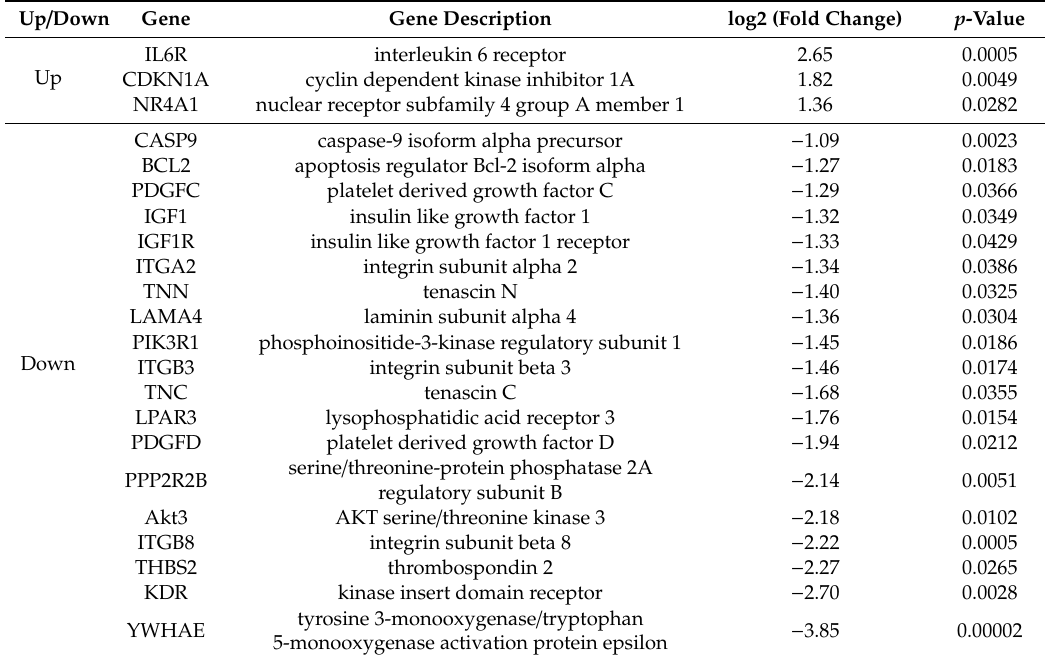
Table 2. Abeliophyllum distichum leaves extract induces di ff erentially expressed genes involved in the phosphoinositide 3-kinase (PI3K) / Akt signaling